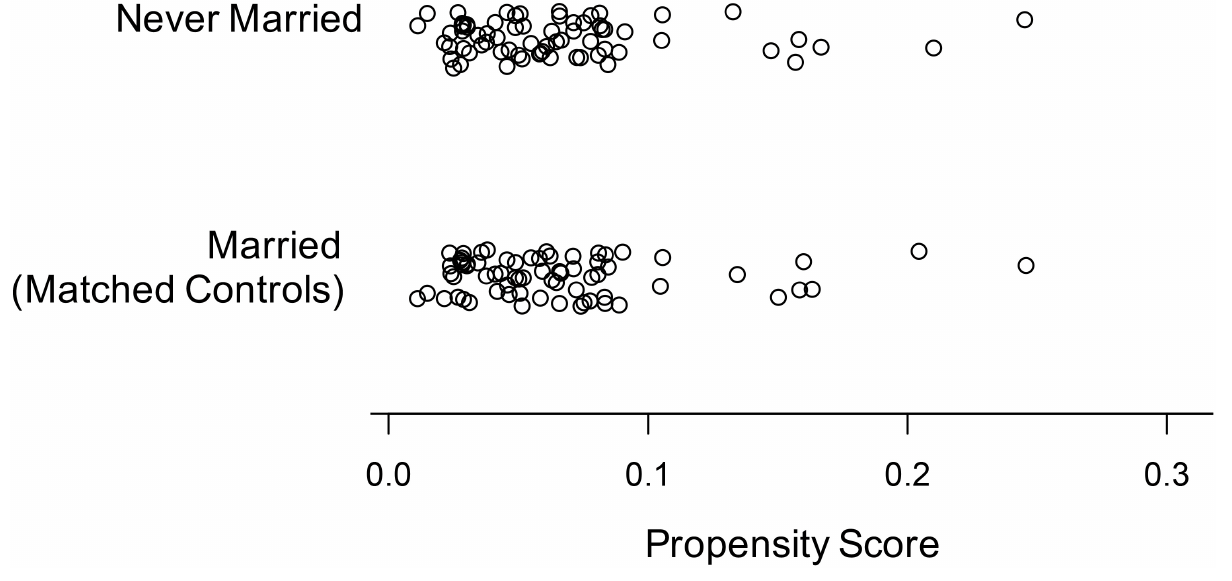
FIGURE 1 | Propensity scores of the never married individuals and the matching married individuals after propensity score